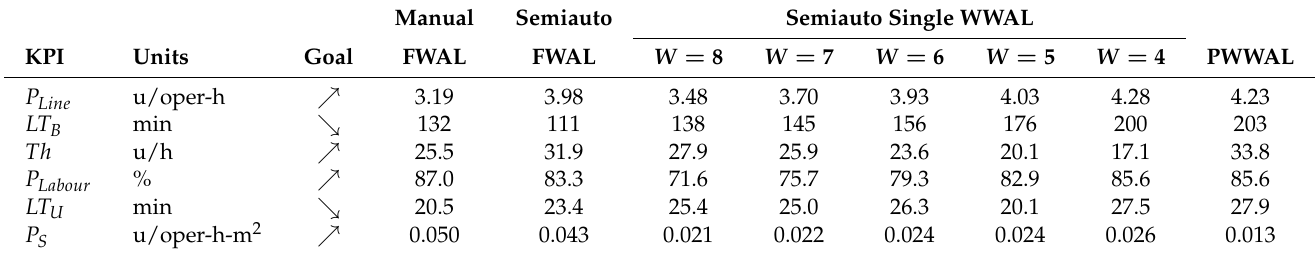
Table 9. Operational KPIs for manual FWAL, semiautomated FWAL, semiautomated single WWAL, and parallel walking-worker assembly line configurations under standard demand conditions ( sce- nario i